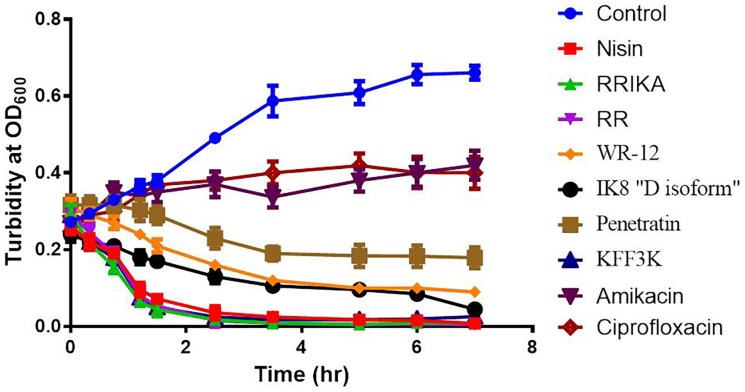
Growth kinetics of SP3 exposed to 5X MIC of peptides, antibiotics and sterile water (control) as measured by OD600 by spectrophotometer over time.Results are representative of two separate experiments, each done in triplicate. Error bars represent standard deviation values.